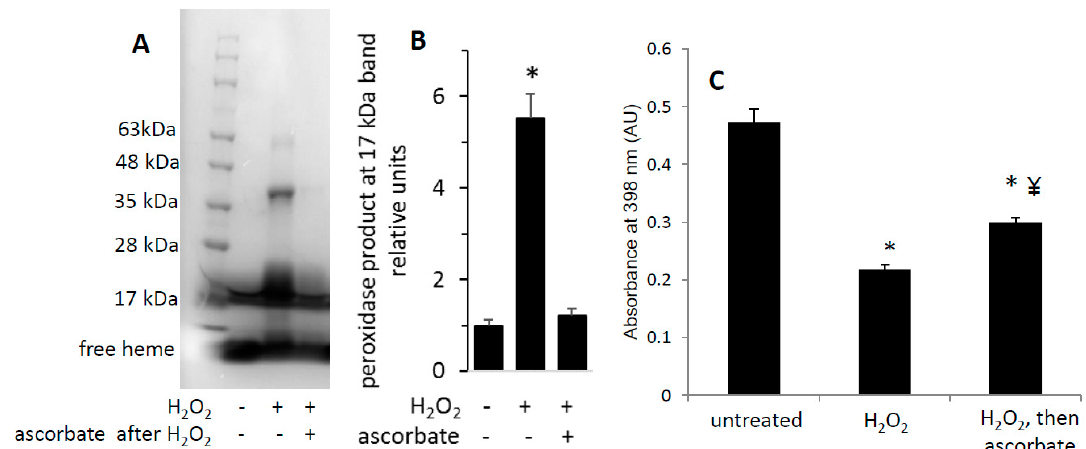
Figure 5. Heme-dependent reaction of H 2 O 2 -oxidized metMb with ascorbic acid is sufficient to reverse heme-protein crosslinks. ( A ) MetMb (111 µM, pH 6.1) was incubated in the absence or presence of 300 µM H 2 O 2 for 10 min prior to adding 833 µM ascorbic acid for an additional 10 min and performing SDS-PAGE followed by ( A ) a heme peroxidase stain. ( B ) Quantitation of the peroxidase product at the 17 kDa band, n = 5/group, * p < 0.001. ( C ) Acid-butanone heme extraction was performed on metMb that was either untreated, reacted with H 2 O 2 alone for 10 min (H 2 O 2 ) or treated with ascorbic acid after 10 min of H 2 O 2 oxidation. Free heme was assessed by absorbance at 398 nm. * p ≤ 0.05 compared to untreated control; ¥ p ≤ 0.05 compared to H 2 O 2 -only; n = 3/group.